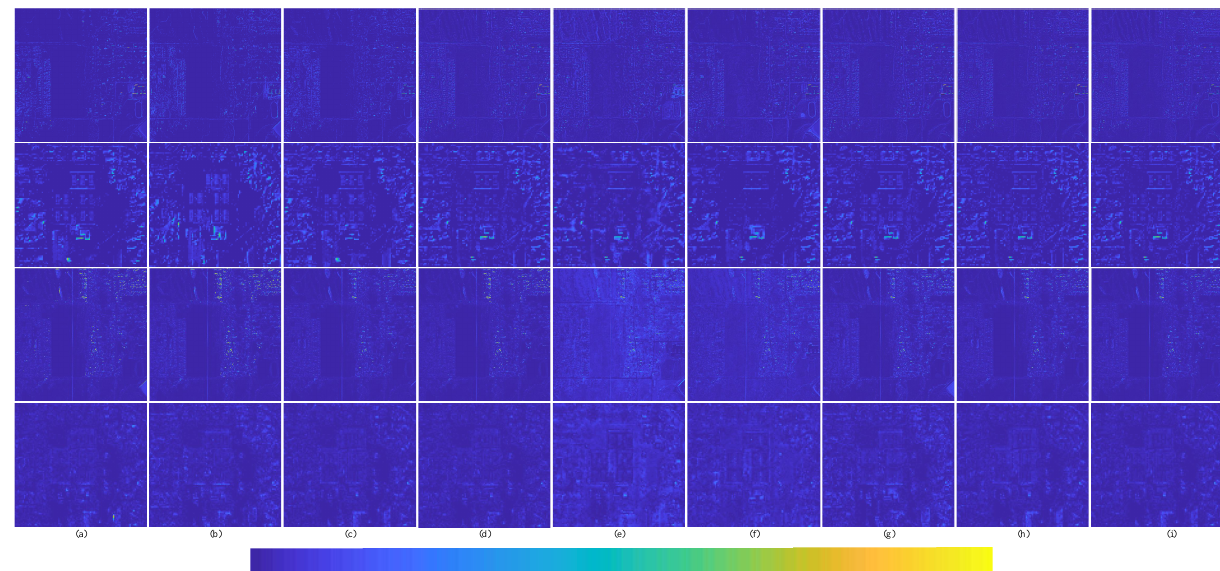
Figure 17. Average intensity difference maps and average spectral difference maps between the pan-sharpened MS image and ground-truth MS image for the QuickBird testing dataset with reduced resolution; the top row are the average intensity difference maps of the whole image, the second row are the average intensity difference maps of the enlarged area in Figure 16, the third row are the average spectral difference maps of the whole image, and the bottom row are the average spectral difference maps of the enlarged area in Figure 16. ( a ) Brovey; ( b ) GS; ( c ) SFIM; ( d ) IFCNN; ( e ) PNN; ( f ) DRPNN; ( g ) PanNet; ( h ) ResTFNet; ( i ) RDFNet (ours).